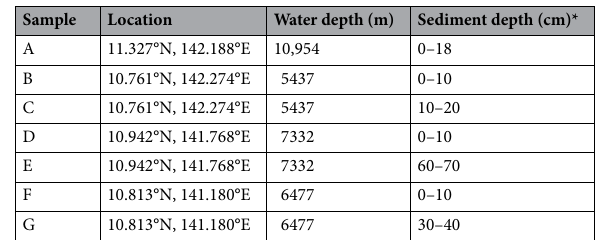
Table 1. Information for sediment samples used in this study. The samples are named A–G. *Approximate depth, as these samples were from subsampling of box